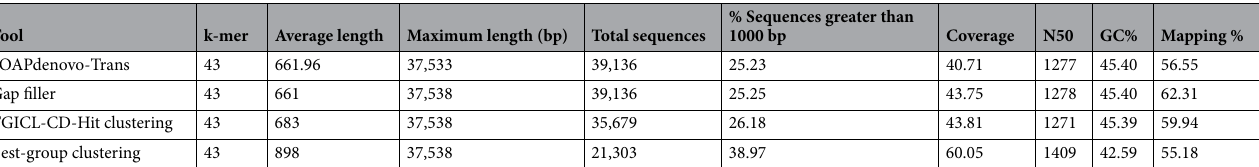
Table 1. Overview of de novo assembly of Rheum australe